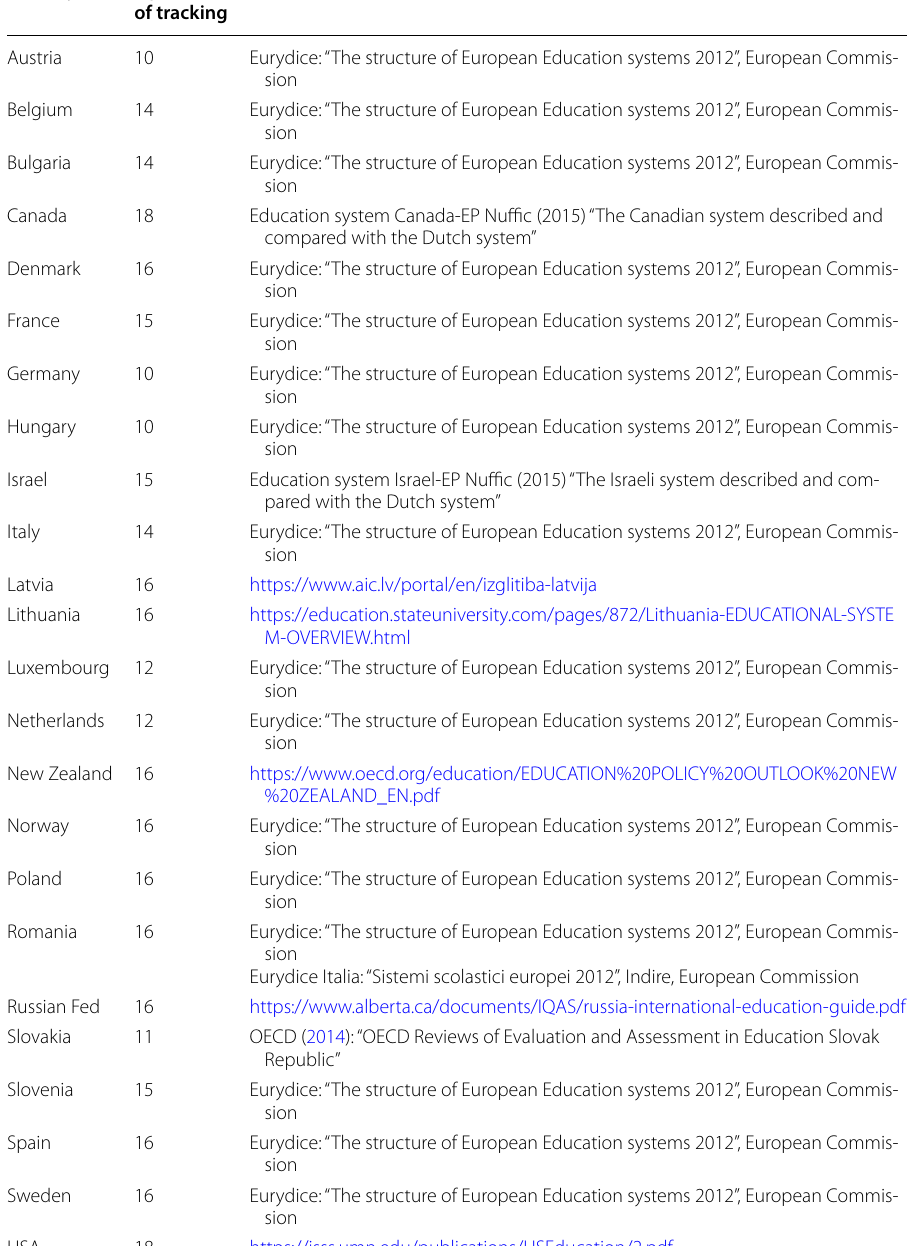
Table 5 Age of tracking by country and data source